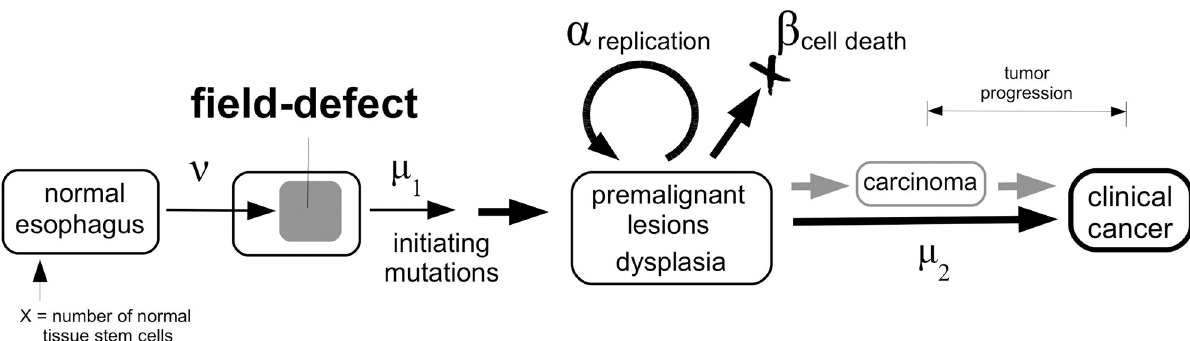
Fig 1. Multistage clonal expansion (MSCE) model for ESCC. Model parameters are: ν the rate of an ESCC predisposing field-defect, μ 1 the mutation rate (per field) for the initiation of premalignant (dysplastic) clones, α the cell division rate, β the cell death rate, and μ 2 the rate of malignant transformations. A lag-time of 5 years is assumed for a viable malignant cell to progress to clinical cancer.